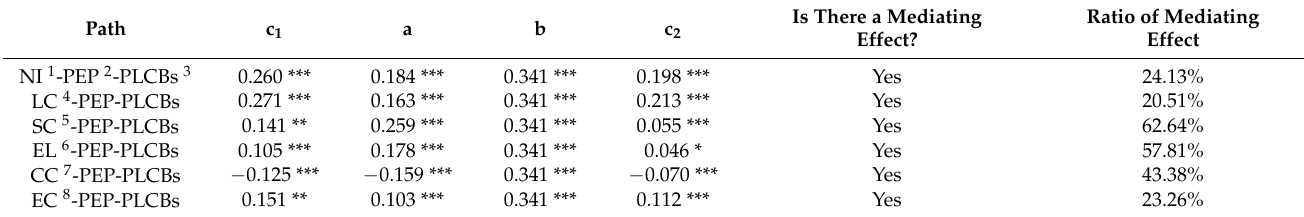
Table 3. Mediating effects of psychological empowerment